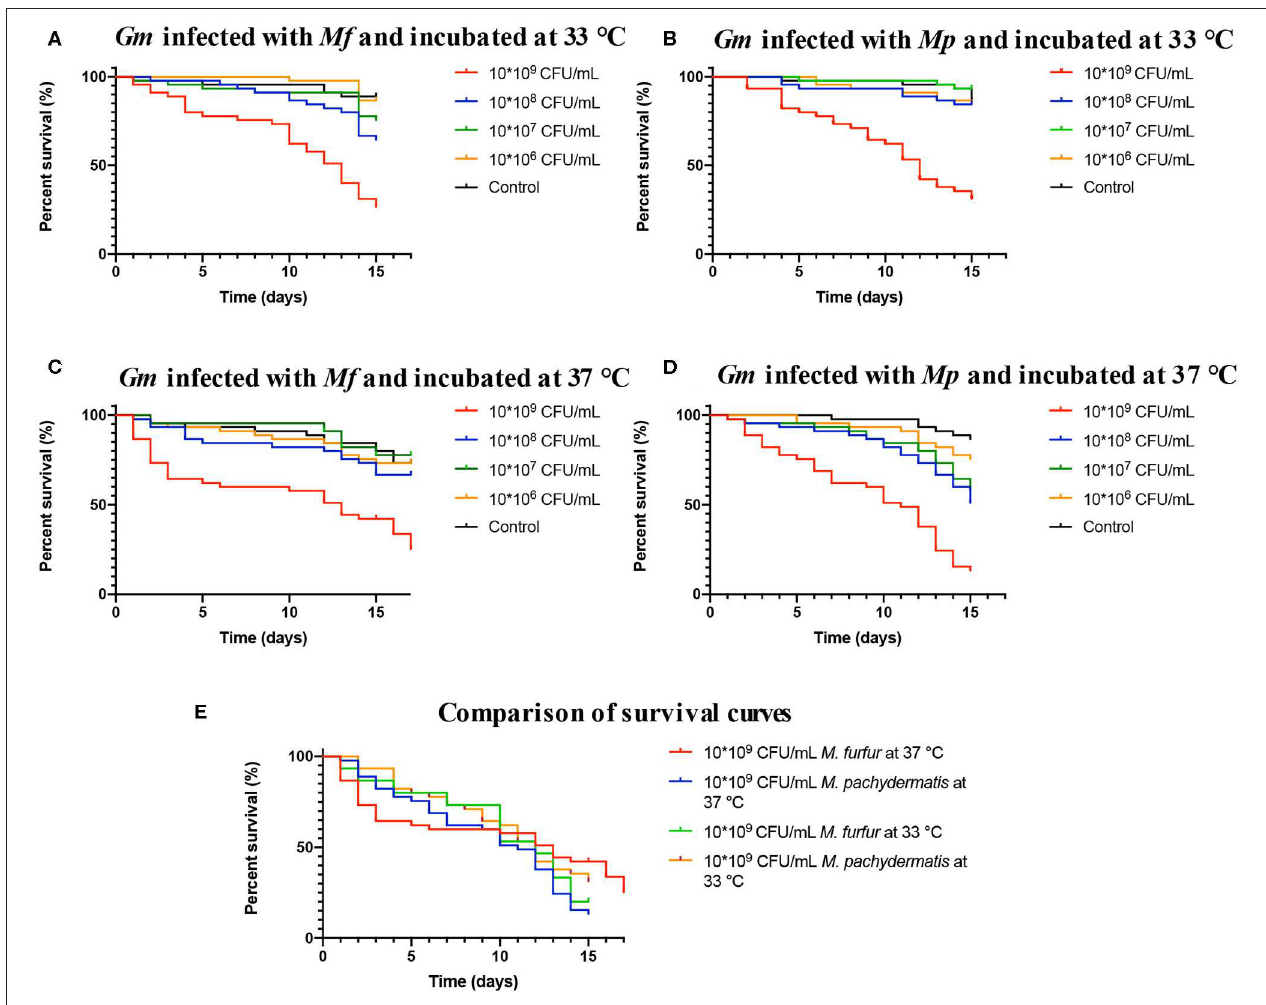
FIGURE 2 | Survival curves of G. mellonella infected with M. furfur and M. pachydermatis . (A) The survival curve of G. mellonella infected with M. furfur and incubated at 33 ◦ C, 50% of mortality is reached on day 13. (B) The survival curve of G. mellonella infected with M. pachydermatis and incubated at 33 ◦ C, 50% of mortality is reached at day 12. (C) The survival curve of G. mellonella infected with M. furfur and incubated at 37 ◦ C, 50% of mortality is reached at day 13. (D) The survival curve of G. mellonella infected with M. pachydermatis and incubated at 37 ◦ C, 50% of mortality is reached at day 12. In general, larvae infected with an inoculum of 1.5 × 10 9 CFU/mL had higher mortality ( p < 0.0001, log-rank (Mantel-Cox) test). (E) Comparison of survival curves of larvae infected with inoculum of 1.5 × 10 9 CFU/mL of M. furfur and M. pachydermatis incubated at 33 and 37 ◦ C, no significant differences were found between the four treatments ( p = 0.2046, log-rank (Mantel-Cox) test). In all cases, survival depended on inoculum concentration. Mf, M. furfur; Mp, M. Pachydermatis; Gm, G. mellonella